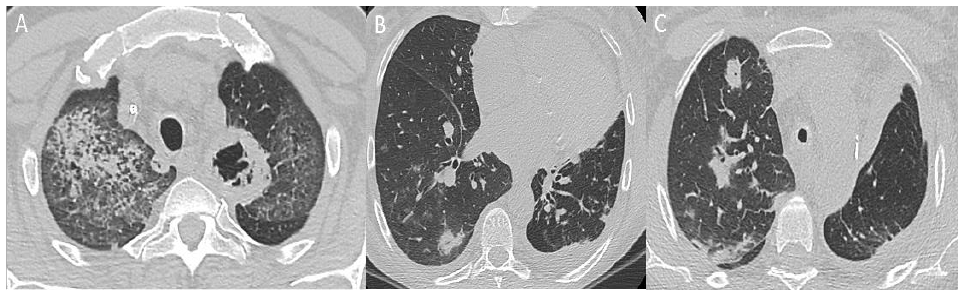
Figure 7. Parenchymal involvement in BD: ( A ) apical-site consolidation with cavitation associated with multiple ground-glass thickening indicating alveolar hemorrhage, a rare presentation of BD; ( B , C ) perivascular and sub-pleural consolidations and diffuse ground-glass opacities.